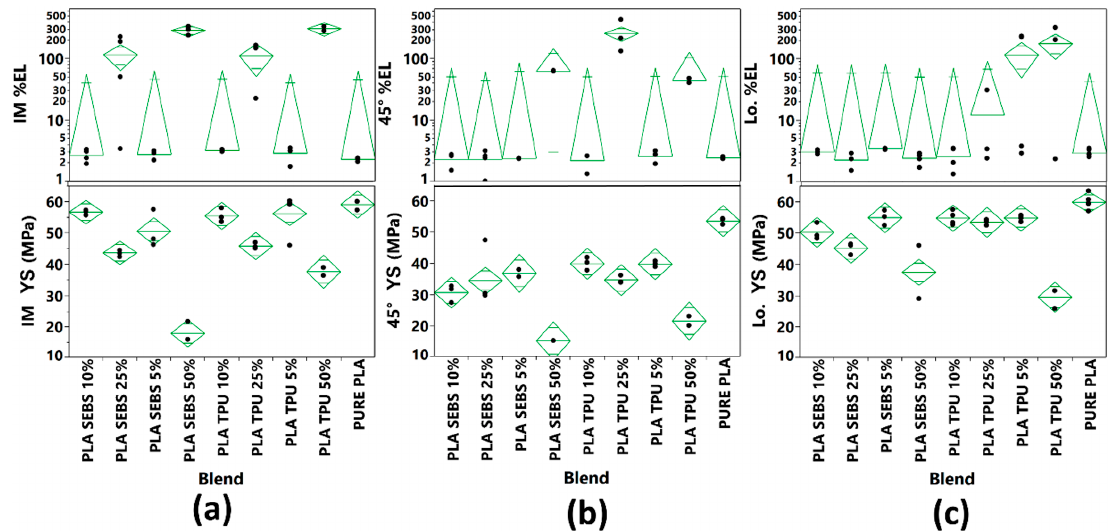
Figure 12. Tensile test data for the blend systems evaluated here for ( a ) injection molding (IM), ( b ) FFF in a 45° raster pattern, and ( c ) FFF in a longitudinal (Lo.) raster pattern.